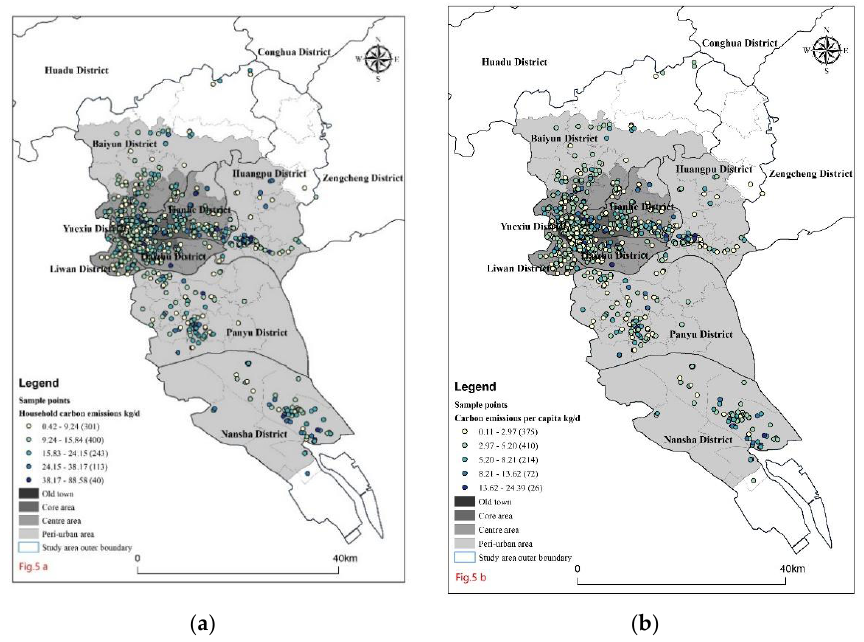
Figure 5. Spatial distribution of household carbon emissions in Guangzhou. ( a ) Household carbon emissions per day. ( b ) Carbon emissions per capita per day.